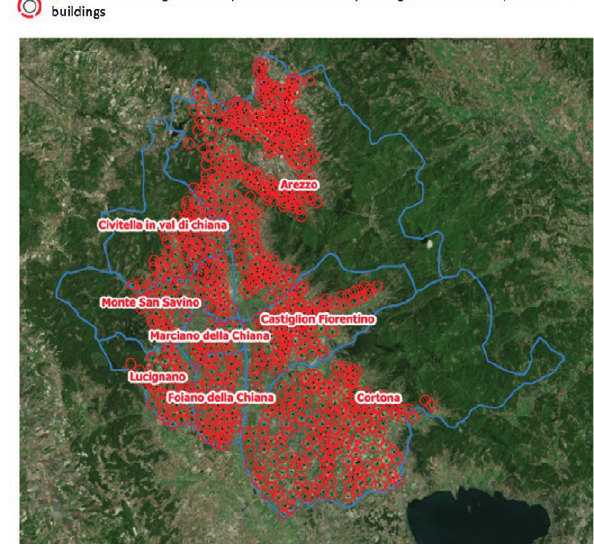
Figure A2.2. Urbanization of rural areas in the Chiana